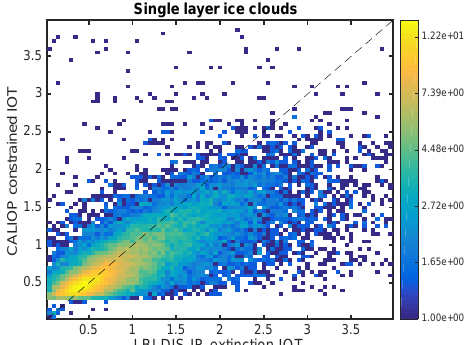
Figure 9. The CALIOP V3 constrained IOT retrieval for single- layer clouds is compared to the LBLDIS reference IOT retrieval. Due to signal-to-noise limitations the comparison is limited to nighttime-only